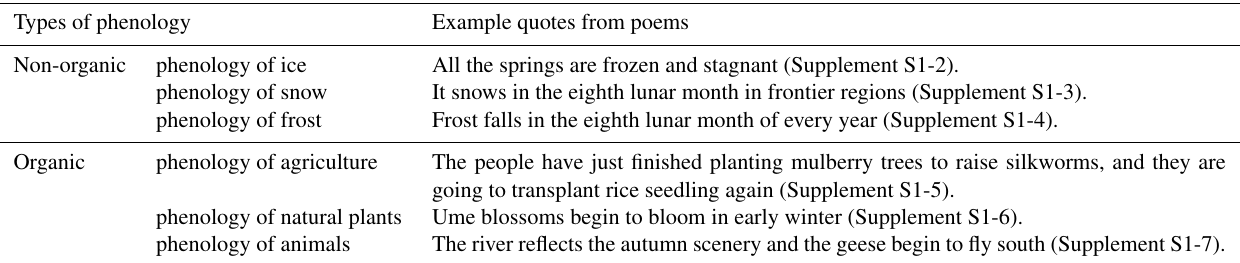
Table 1. Different types of phenology in poems from the Tang and Song dynasties. Types of phenology